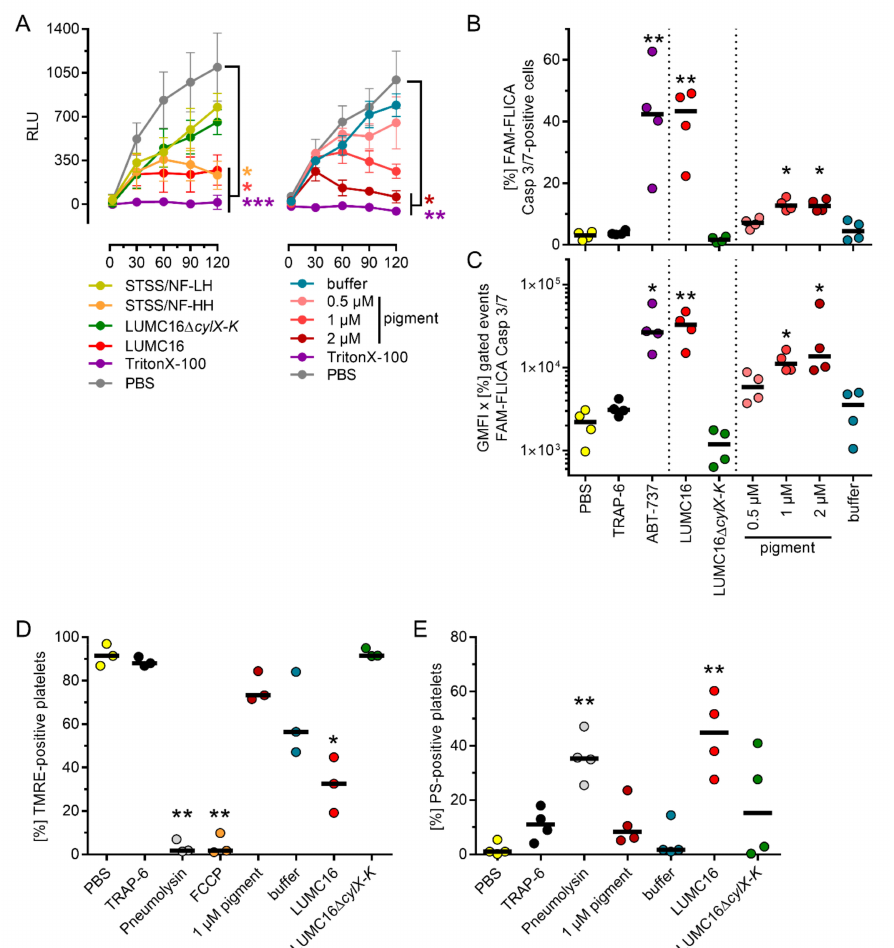
Figure 3. GBS pigment kills platelets. ( A ) Kinetics of platelet viability. PBS and TritonX-100 were used as negative and positive controls, respectively. ( B , C ) Caspase-3/7 activity in GBS-infected or pigment-treated platelets after two hours of exposure. The process was evaluated by assessing frequencies of Caspase 3/7-positive cells ( B ) as well as expression of Caspase 3/7 ( C ). PBS and ABT-737 (10 µ M) were used as negative and positive controls, respectively. ( D ) Frequencies of TMRE- positive platelets after two hours of exposure to bacteria or pigment. Pneumolysin (300 ng/mL) and FCCP (20 µ M) were used as controls. ( E ) Frequencies of PS-positive platelets after two hours of exposure to bacteria or pigment. Pneumolysin (300 ng/mL) was used as a control. Each dot in A represents the mean ± SD from four independent experiments ( n = 4). Each dot in B-E represents one independent experiment with cells from one donor (B and C, n = 4; D, n = 3; E, n = 4). Horizontal lines depict mean values. The level of significance was determined using Kruskal-Wallis tests with Dunn’s post-tests (*, p < 0.05; **, p < 0.01; ***, p < 0.001). Abbreviations (GMFI, geometric mean of fluorescence intensity; RLU, relative luminescence units; TMRE, tetramethylrhodamine ethyl ester; FCCP, carbonyl cyanide 4-(trifluoromethoxy) phenylhydrazone; PS,